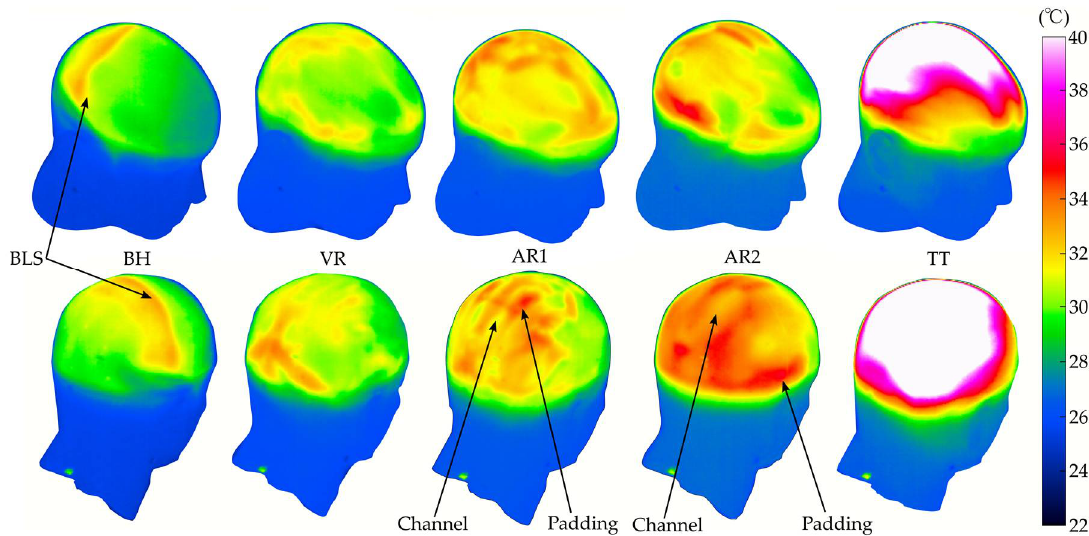
Figure 3. Front and rear thermal images of the heated head at the end of testing, shortly after the helmet has been removed. The clear line on BH is the point of boundary layer